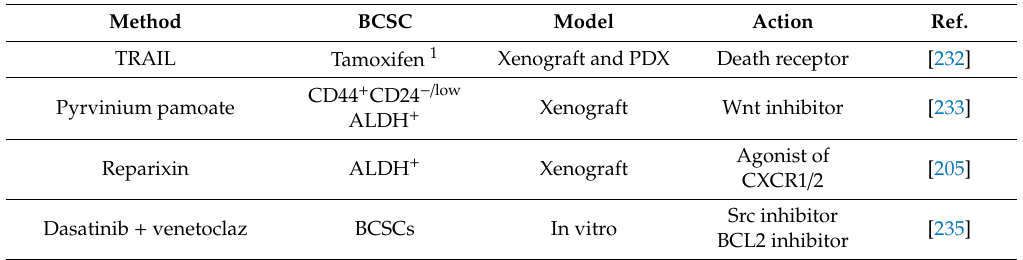
Table 2. Strategy of targeting BCSCs associated with endocrine therapy resistance.